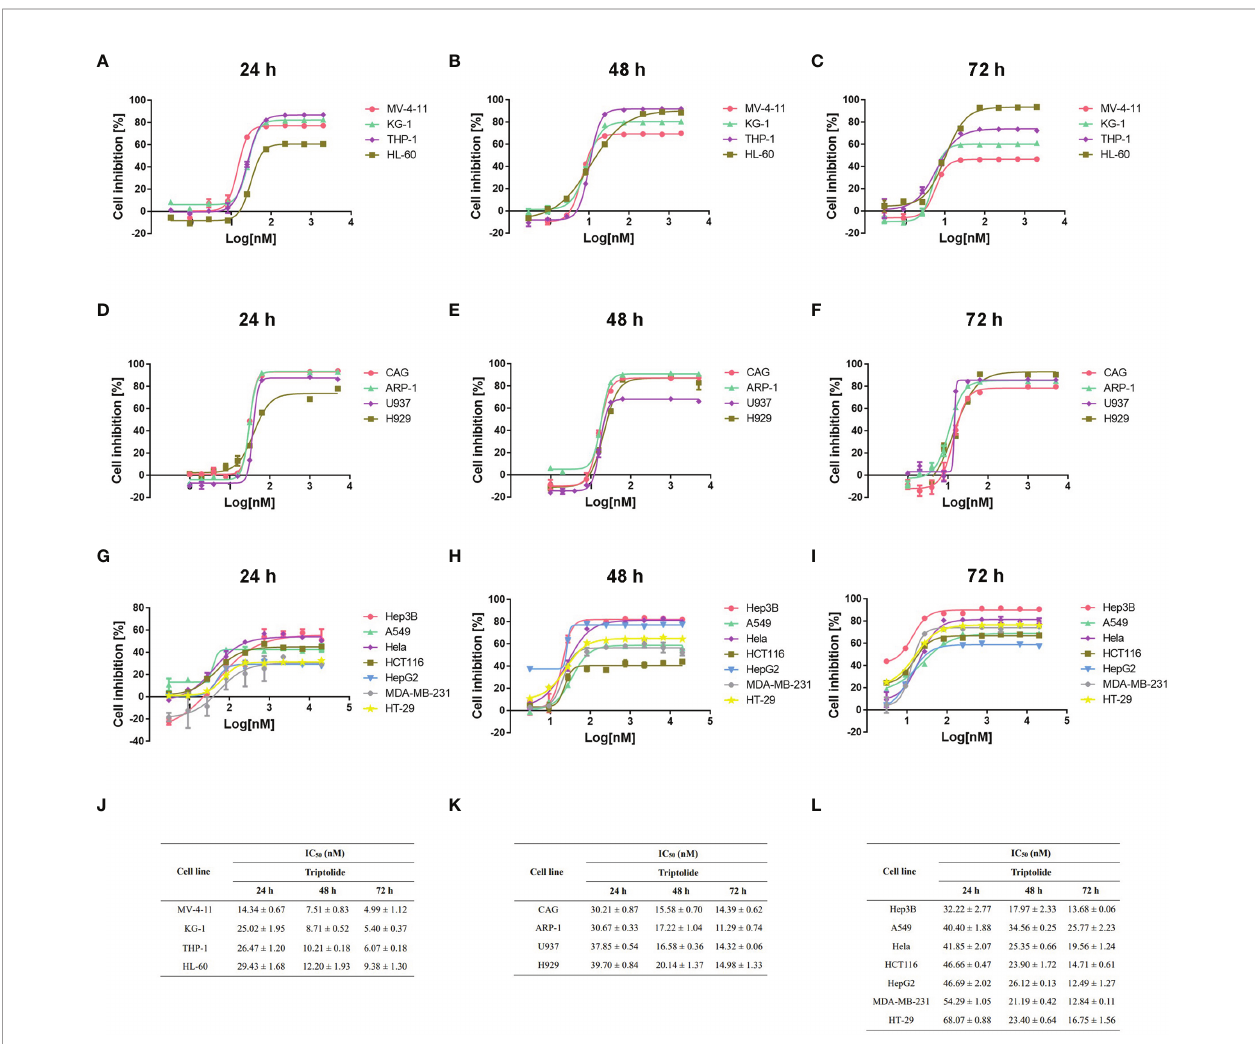
FIGURE 1 | Triptolide induces cytotoxic effects on different cell lines in vitro . (A – I) Fifteen different cell lines, including AML (A – C) , other hematological cell lines (D – F) and solid cancer cell lines (G – I) were exposed to triptolide for 24 hours (A, D, G) , 48 hours (B, E, H) and 72 hours (C, F, I) , respectively. Cell viability was analyzed using cellular cytotoxicity assays. (J – L) IC 50 values in different cell lines for triptolide are shown. The data is expressed as the mean ± SD based on three independent